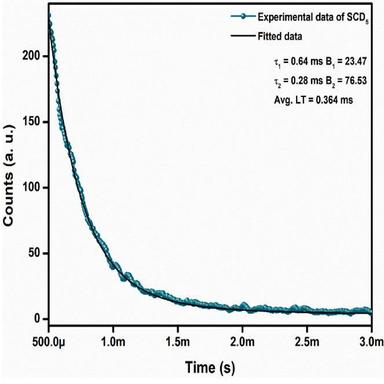
Life-time decay plot of SCD5.